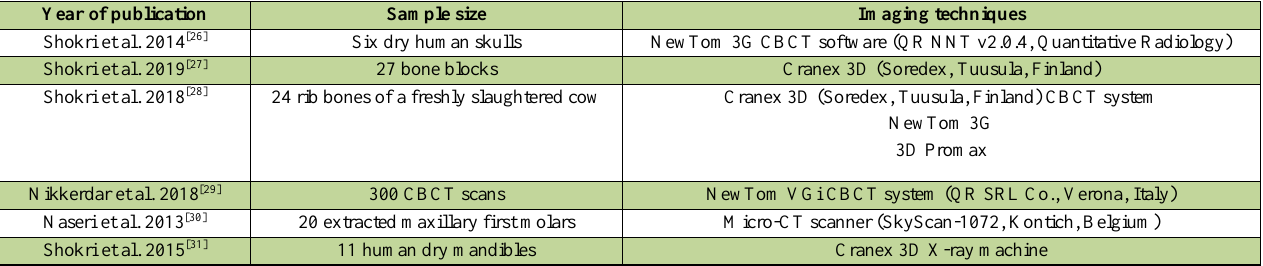
Table 2. Outcomes of studies selected for systematic